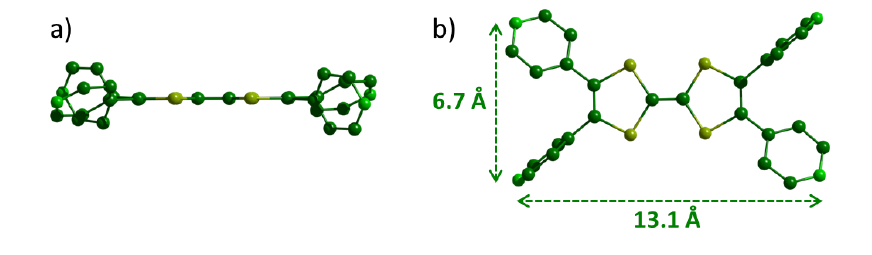
Figure 1. X-Ray structure of ligand L1 : ( a ) side view and ( b ) top view.